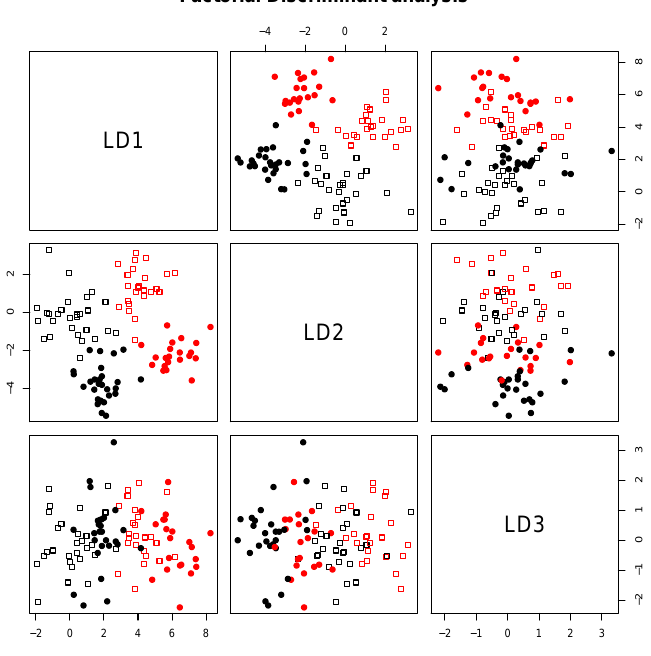
Figure 6. Scatter plot of the component of the factorial discriminant analysis for the illustrative